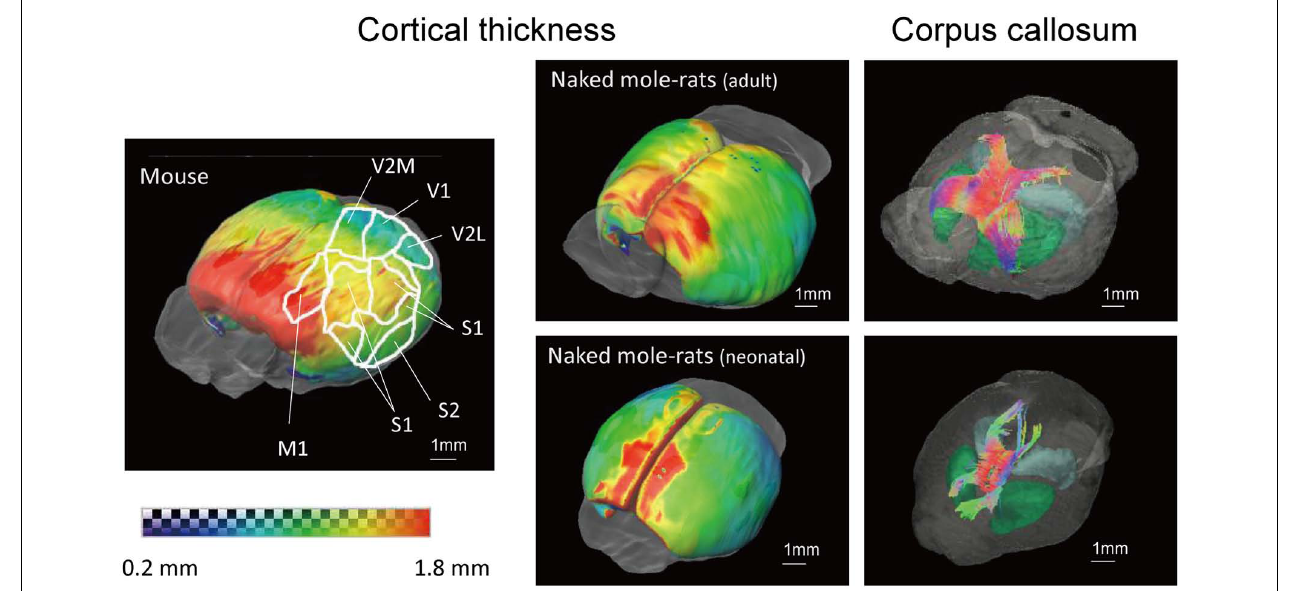
FIGURE 6 | 3D surface maps showing cortical thickness and images of corpus callosum of the adult (above right) and neonatal (below right) naked mole-rats brain, and the mouse brain that maps major sensory systems (left). Thickness is indicated by color as follows: (dark blue, 0.2 mm to red, 1.8 mm).Whole brain images with the corpus callosum are shown to